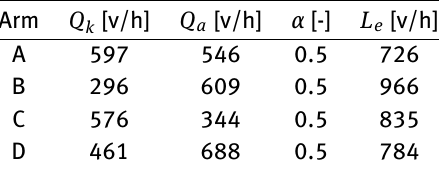
Table 3: Capacity of the entrances. Source: authors.